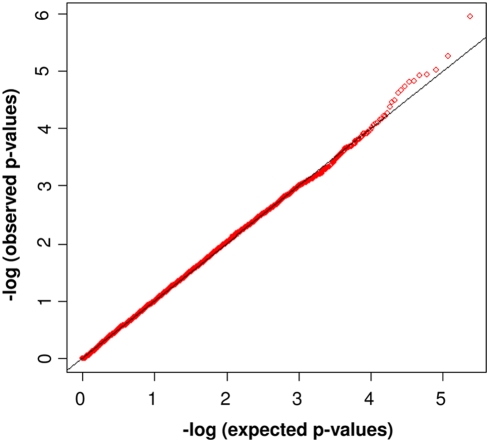
Quantile-Quantile Plot of Allelic Distributions.Allelic association analysis of expected versus observed P-values of 223,922 SNPs in 107 KD cases and 134 controls. Red dots showing deviations from the line of equality indicate either that the theoretical distribution was incorrect, or that the sample was contaminated with values generated by a true association.